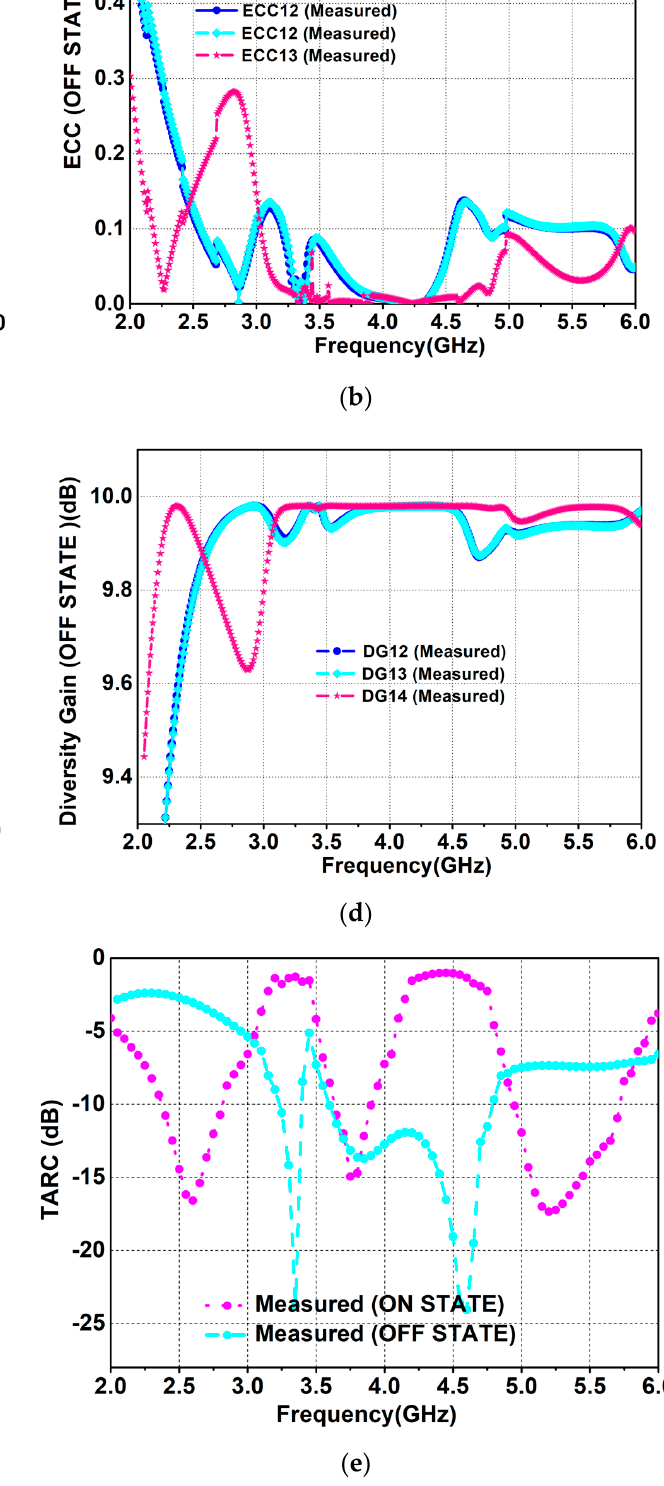
Figure 12. Performance of the MIMO/diversity attributes for modes-1 and -2: ( a ) ECC (ON state); ( b ) ECC (OFF state); ( c ) DG (ON state); ( d ) DG (OFF state); ( e ) TARC.